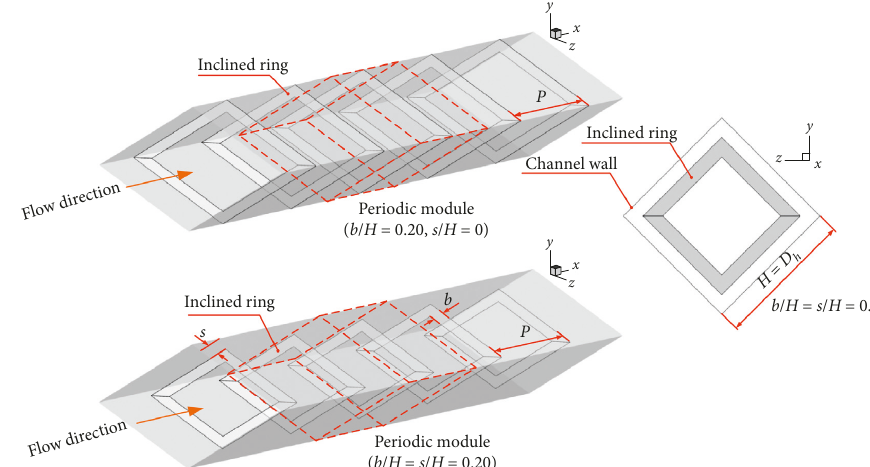
Figure 1: Computational domain of the heat exchanger square duct installed with the 45 ° ISR.